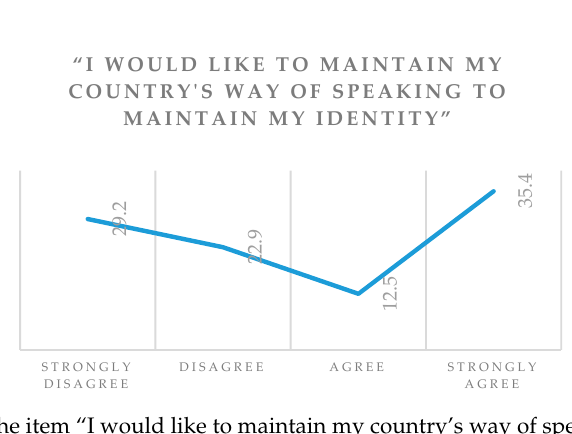
Figure 9. Results of the item “I would like to maintain my country’s way of speaking to maintain my identity”.